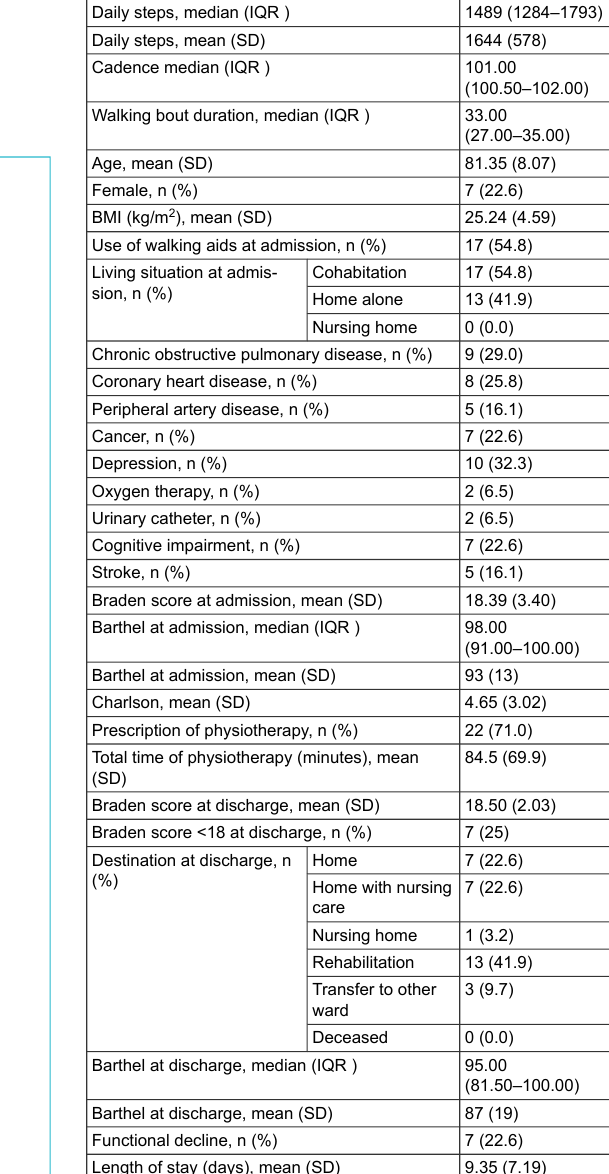
Table S1: Characteristics of patients walking more than 1000 steps per day (n